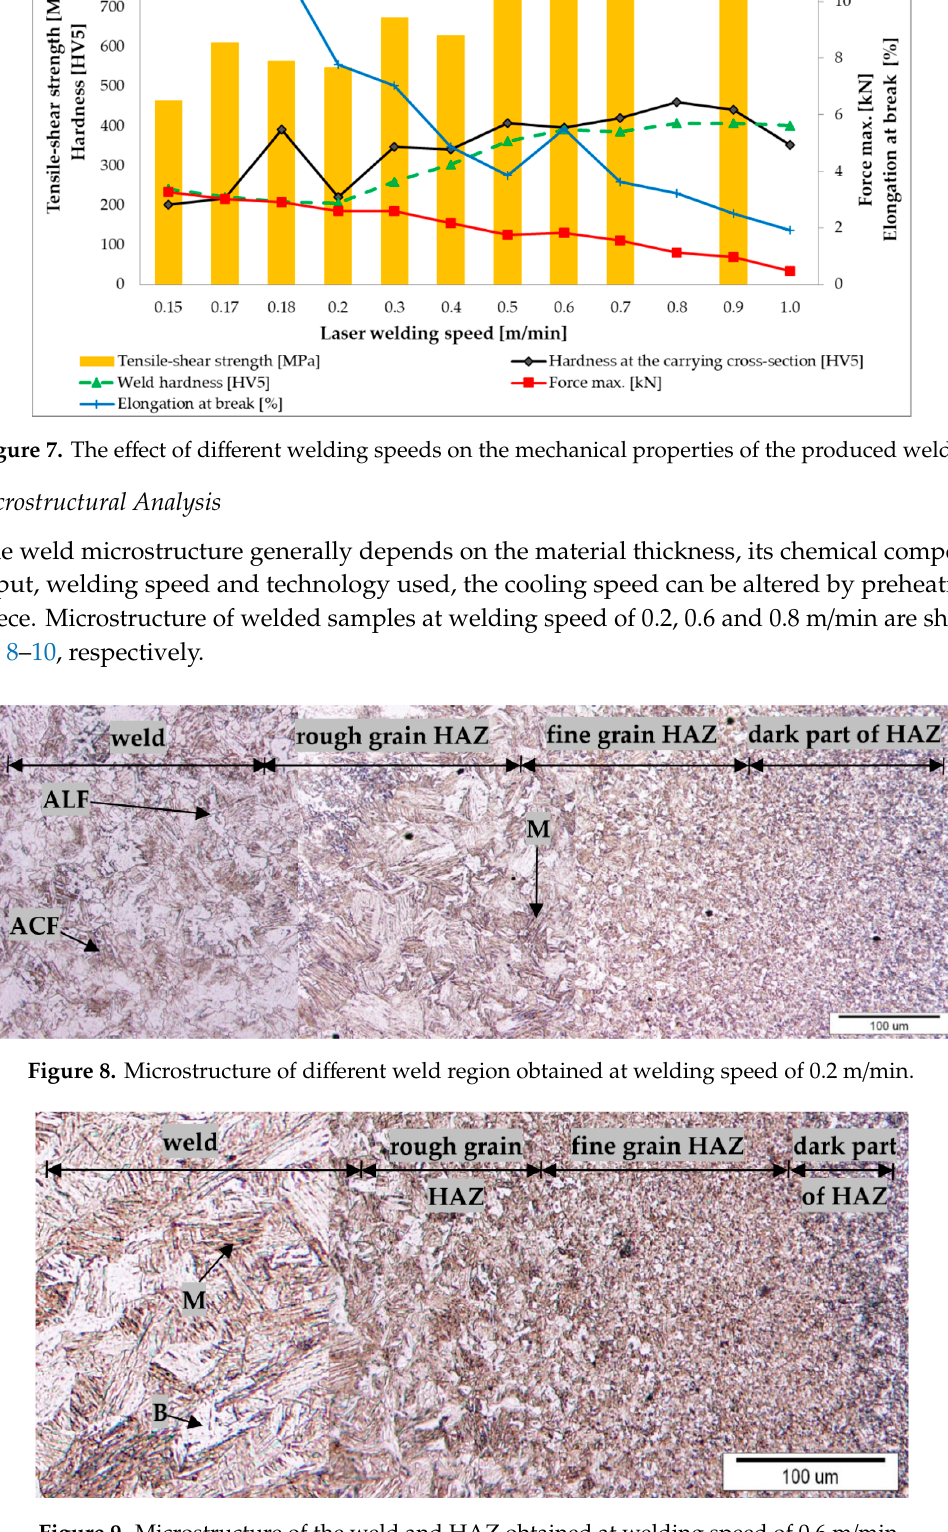
Figure 9. Microstructure of the weld and HAZ obtained at welding speed of 0.6 m/min.